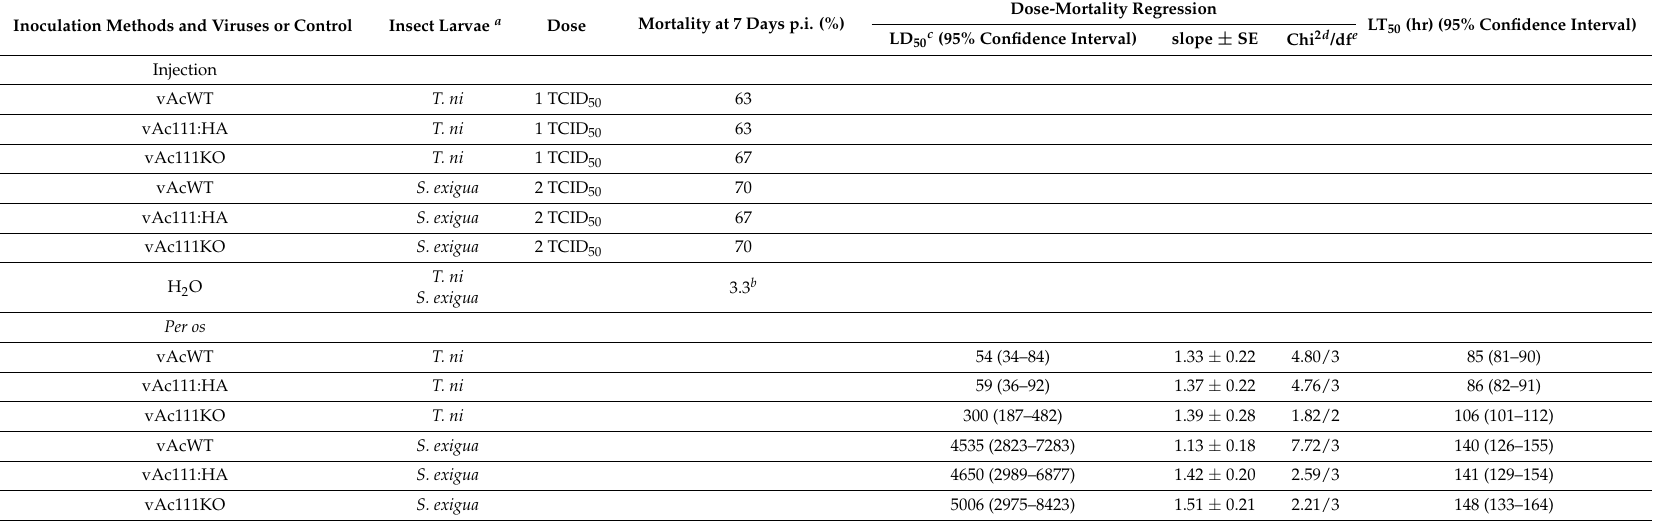
Table 2. Dose-mortality and time-mortality responses of insect larvae infected with different